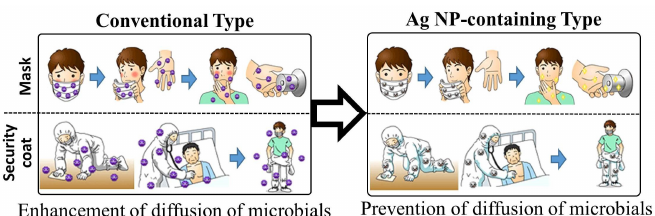
Figure 4. The microbicidal/antiviral activity of materials using Ag NPs/CNFS with various concentration of Ag NPs [48]. The activities of various concentrations of Ag NPs on CNFS against E. coli ( a ) and H1N1 Influenza A ( b ). Data are mean value ± standard deviation ( n = 6); the asterisk indicates a statistically significant difference ( p < 0.01) using two-sample t-test vs. control. ND means non-detection. The vertical axis is listed with a common logarithm. For example, with an Ag NP concentration of 8.5 μg/cm 2 in the CNFS in ( b ), there was a reduction of greater than 2 log10 (100-fold) corresponding to a reduction of viral titers by approximately 99%.